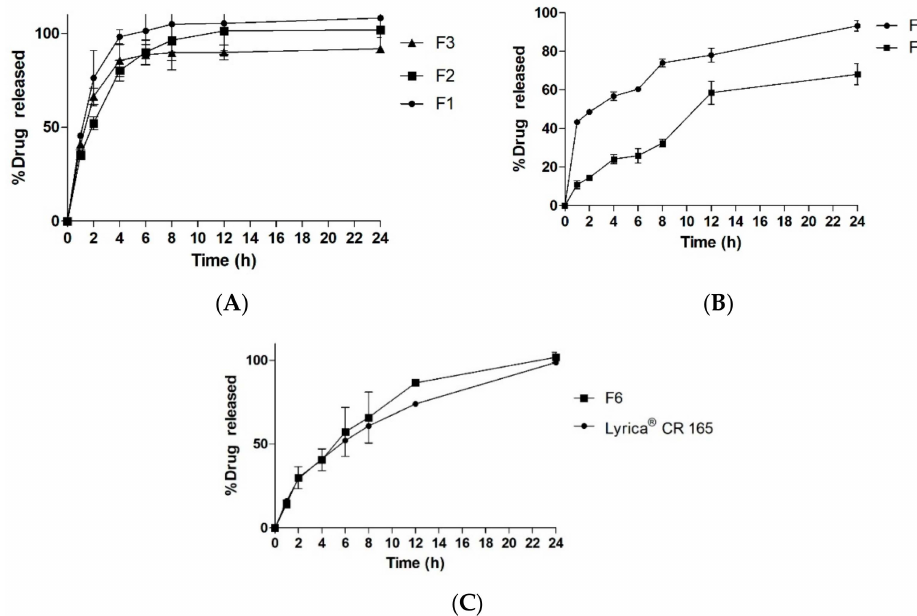
Figure 7. In vitro drug release study. Closed systems ( A ), open systems ( B ), and optimized formulation with commercial product ( C